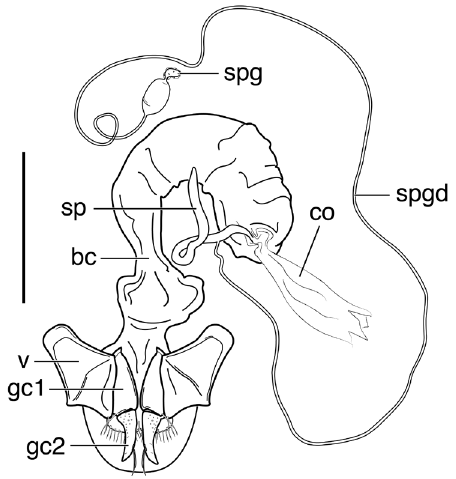
Figure 56. Line drawing of female reproductive tract of Selenophorus parumpunctatus species group, in part, ventral aspect, S. parumpunctatus Dejean. Legend: bc bursa copulatrix co common oviduct gc1 gonocoxite 1 gc2 gono-